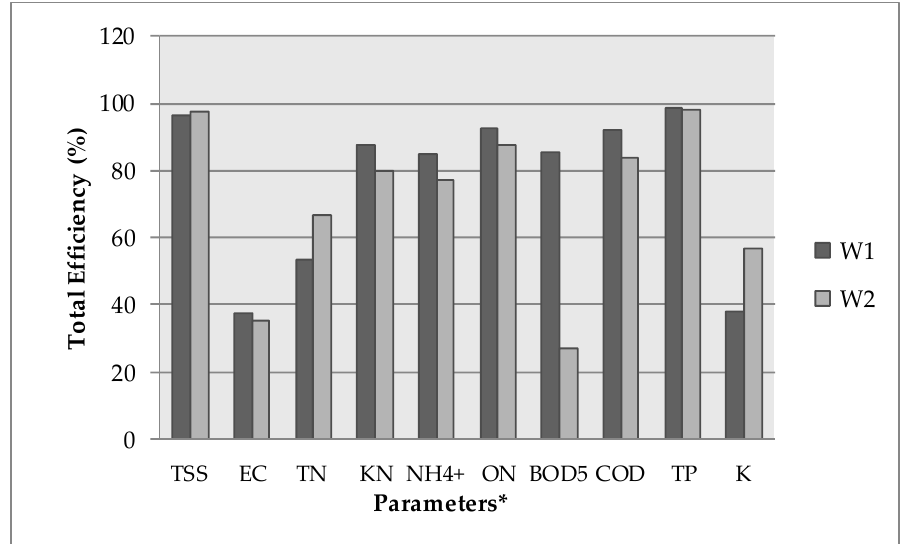
Figure 3. Total e ffi ciency of the main parameters. *TSS total suspended solids, EC electrical conductivity, BOD 5 biochemical oxygen demand COD chemical oxygen demand, TN total nitrogen, KN Kjeldahl nitrogen, ON organic nitrogen, TP Total phosphorous, P potassium.